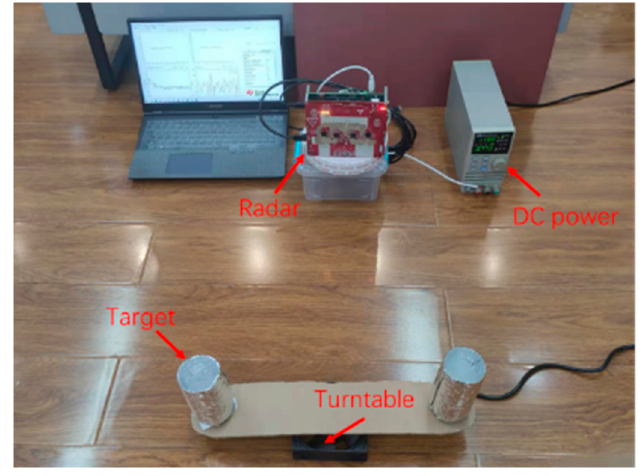
Figure 18. The experimental setup. Table 5. Radar parameter